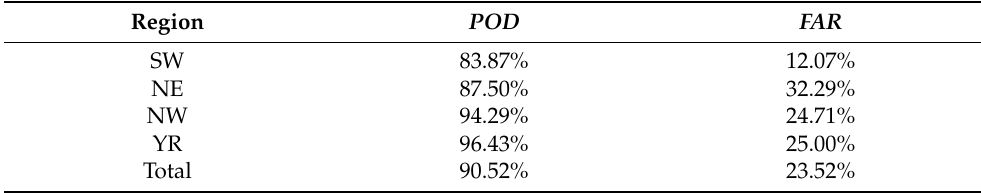
Figure 6. The drought characteristics determined by the calibrated drought characterization approach during 2006~2015. Table 6. The POD and FAR of the drought event characterization approach in four different regions during 2006 and